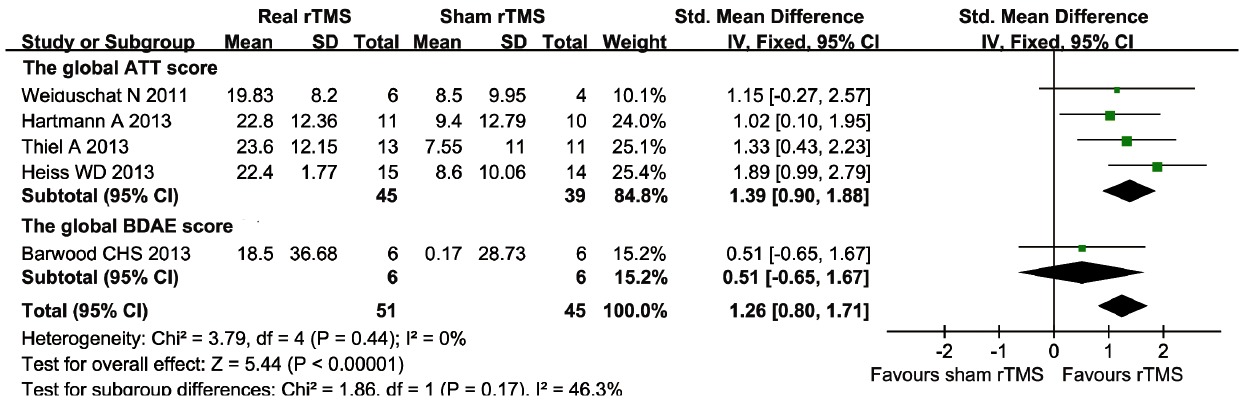
Figure 3. Forest plot of SMD and 95% CI for the severity of language impairment in patients received rTMS and sham rTMS.